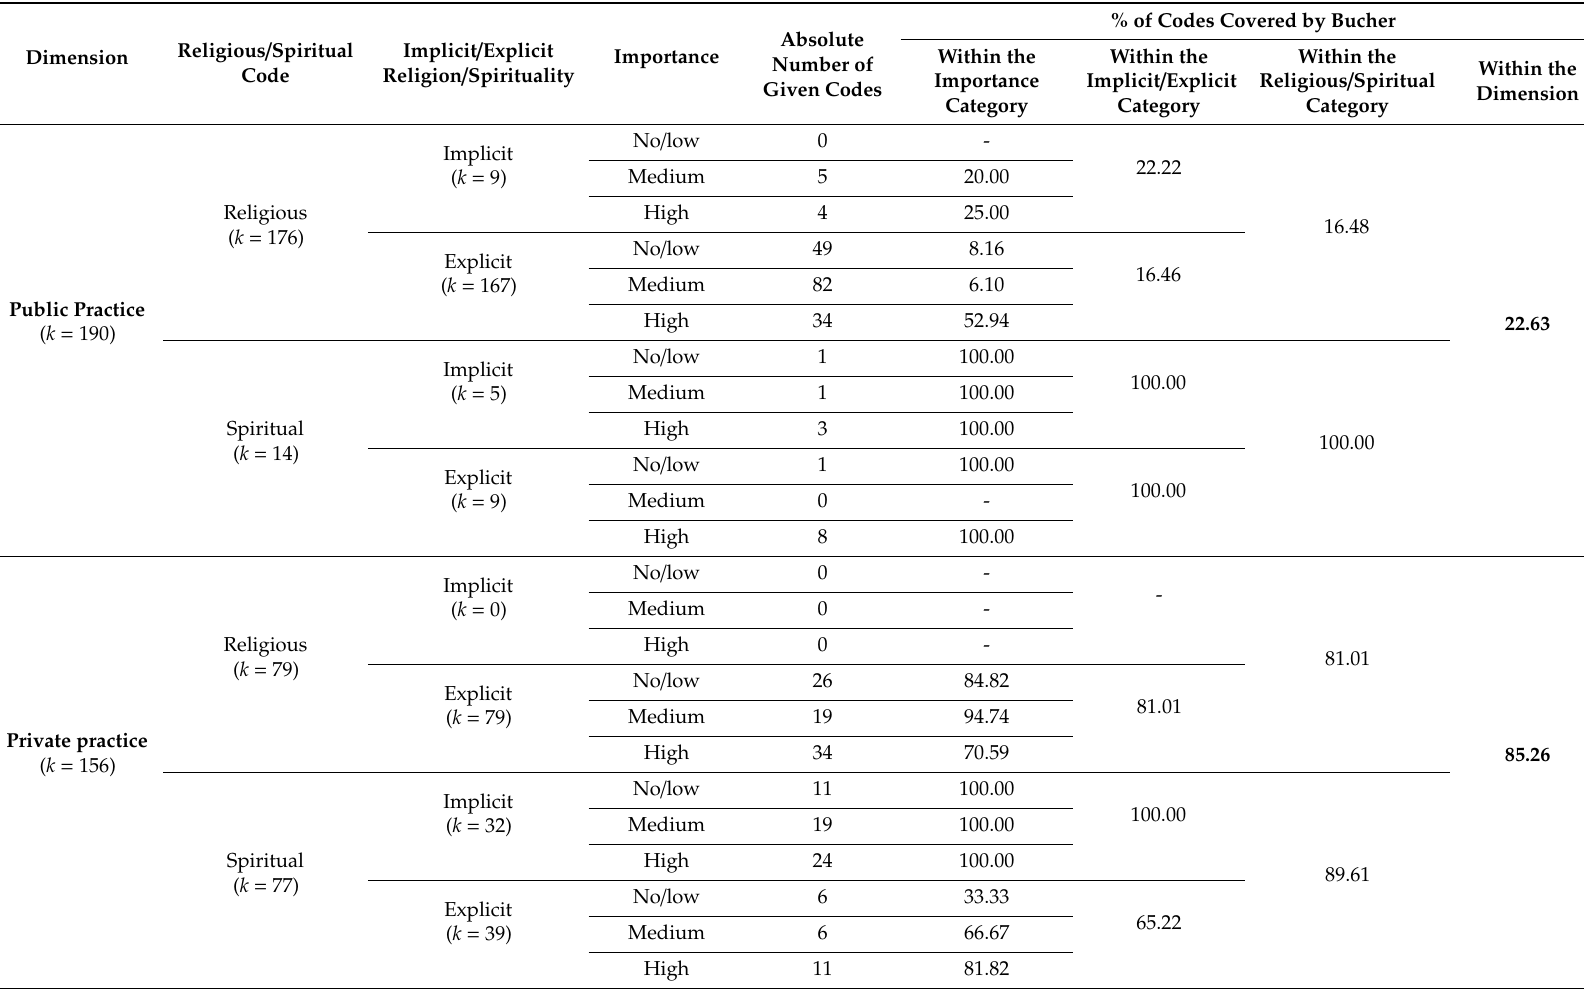
Table 3. Contingency analysis of Bucher’s model and Huber’s